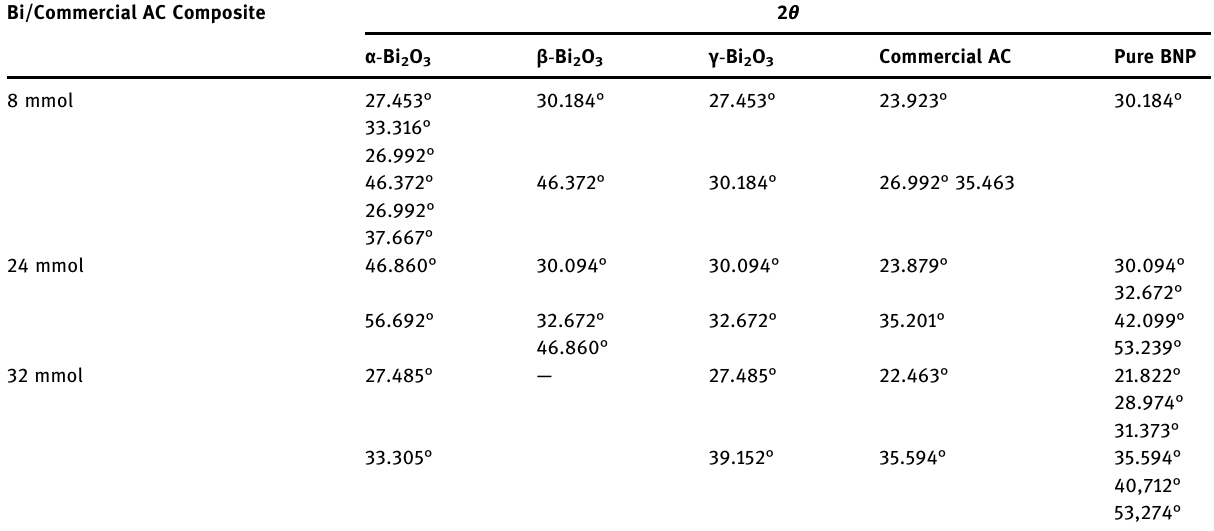
Table 2: XRD 2 θ data comparison of the composite samples with Bi 2 O 3 ( JCPDS ) , commercial AC, and pure BNP